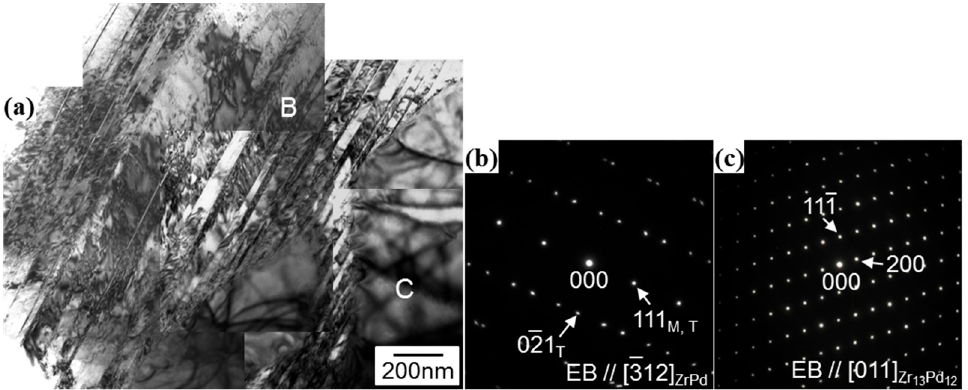
Figure 2. Bright field image in the Zr-49 atom % Pd alloy aged at 1073 K for 720 ks. ( b , c ) Electron diffraction patterns taken from the areas marked B and C in ( a ), respectively. The pattern shown in ( b ) consists of two sets of reflections, showing a (111) ZrPd twin pattern, and the platelet is a (111) ZrPd twin. The pattern shown in ( c ) is indexed according to the orthorhombic Zr 13 Pd 12 compound.